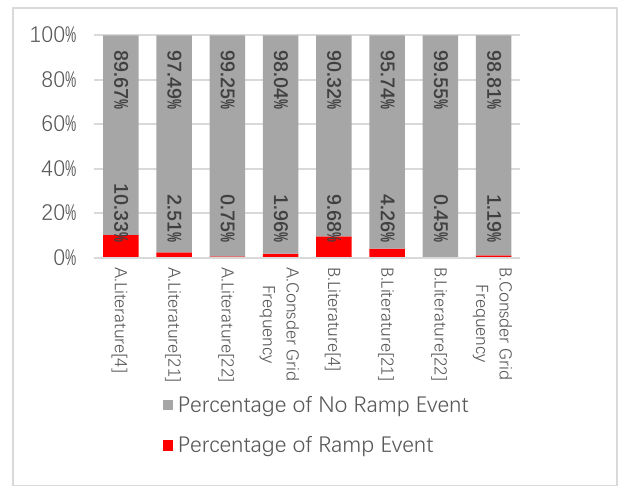
Figure 6. The proportion of ramp events after dividing by the threshold value.